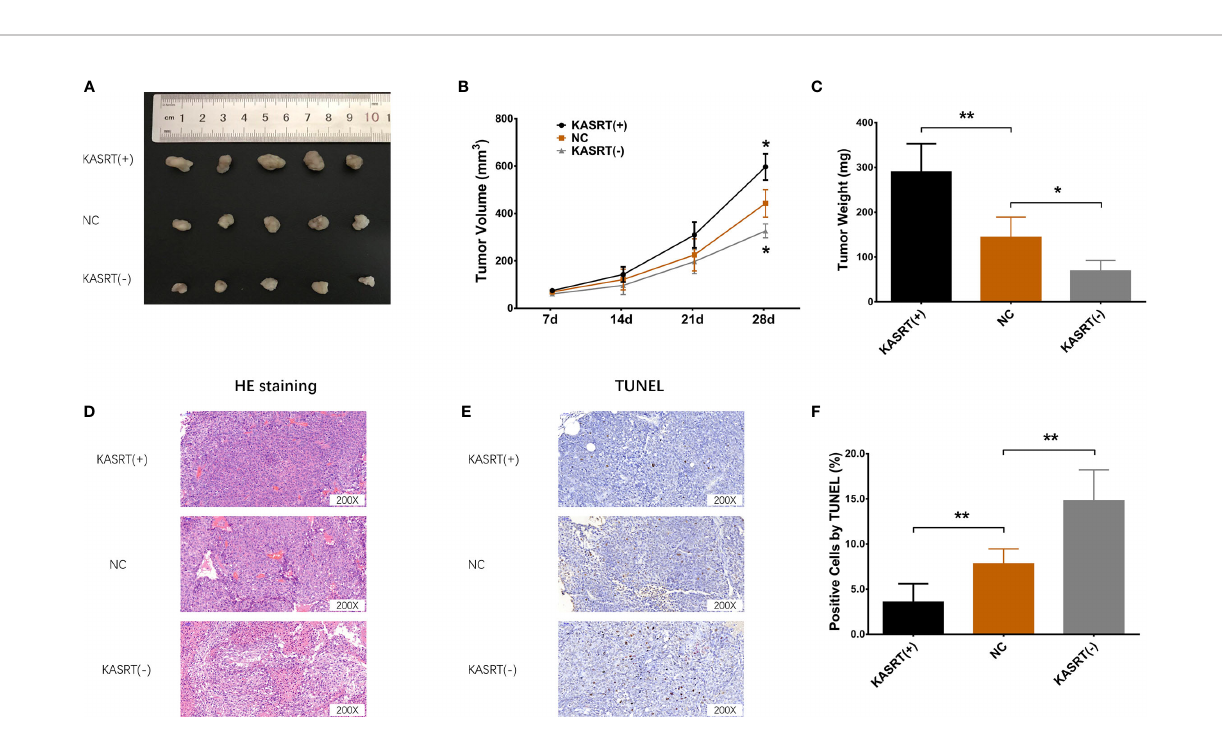
FIGURE 9 | Osteosarcoma tumor growth and apoptosis. Tumor volume (A, B) , tumor weight (C) , HE staining (D) , and TUNEL staining (E, F) among the cell groups. *P < 0.05, **P <